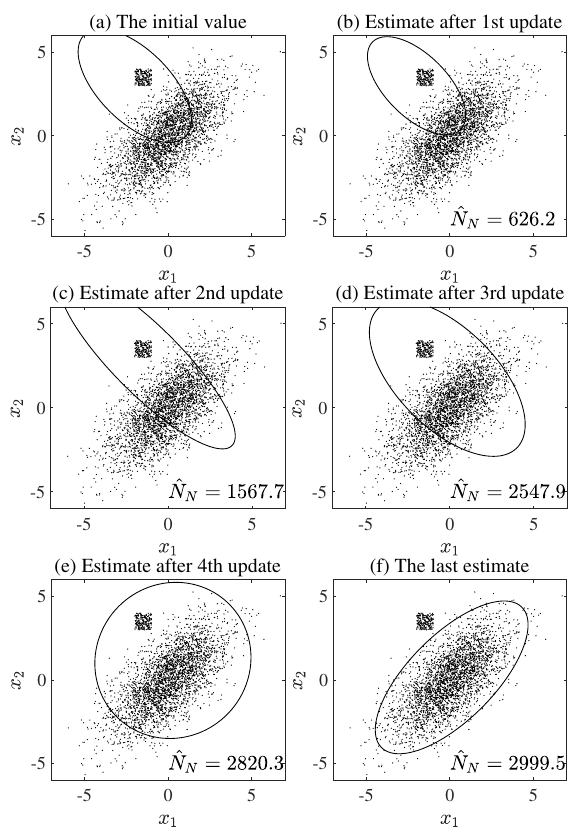
Figure 3. Updates of the estimated major